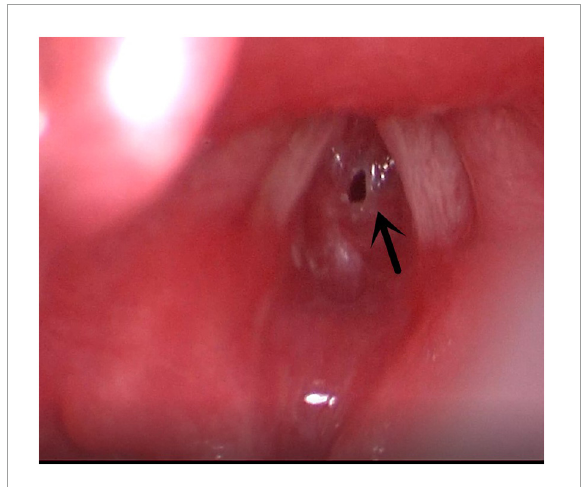
FIGURE5 Subglottic stenosis. Arrow indicates subglottic stenosis because of endotracheal intubation.